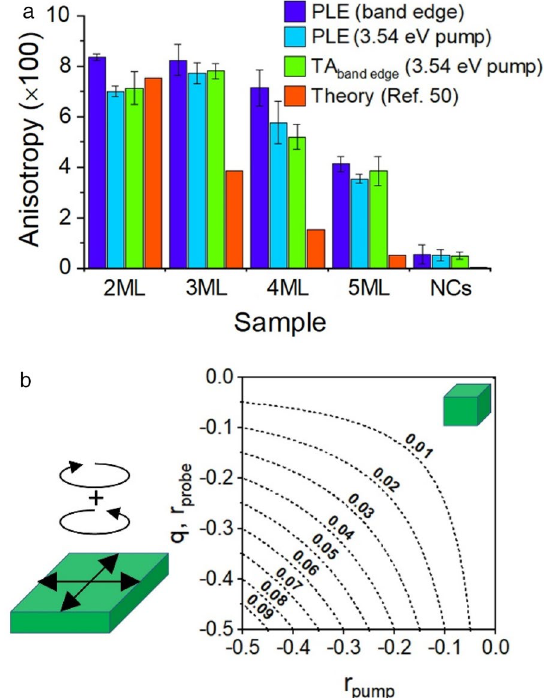
Fig. 5 a Summary of optical ansiotropy results for the CsPbBr 3 NPLs and NCs. Bar graphs of photoluminescence excitation (PLE) data and transient absorption (TA) data are shown. b Plot of the theoretical values of photoselection anisotropy of an ensemble of two-dimensional emitters with larger, degenerate dipole strength in-plane, or, equivalently, circular-polarized optical